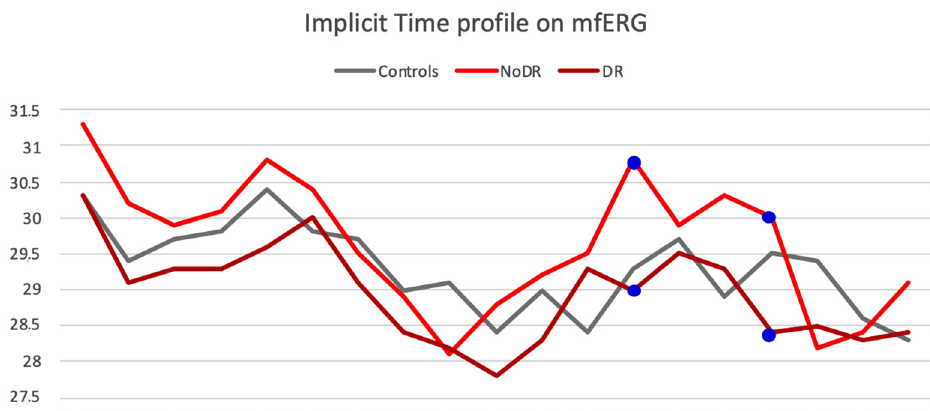
Figure 5. Representation of the implicit time (IT) on multifocal electroretinography (mfERG) waves in controls, no Diabetic Retinopathy (DR) and DR groups. In hexagon 13 and 16 there is a significantly increased IT in the noDR versus the DR group ( p = 0.0273 and p = 0.0471, respectively).